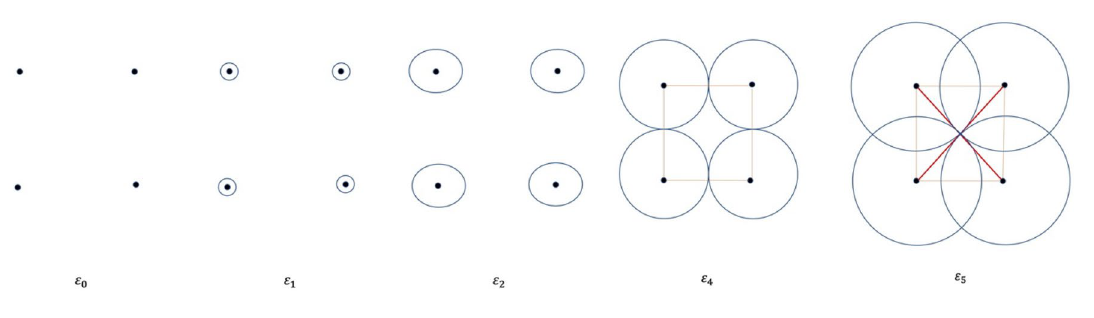
Figure 2. Filtered simplicial